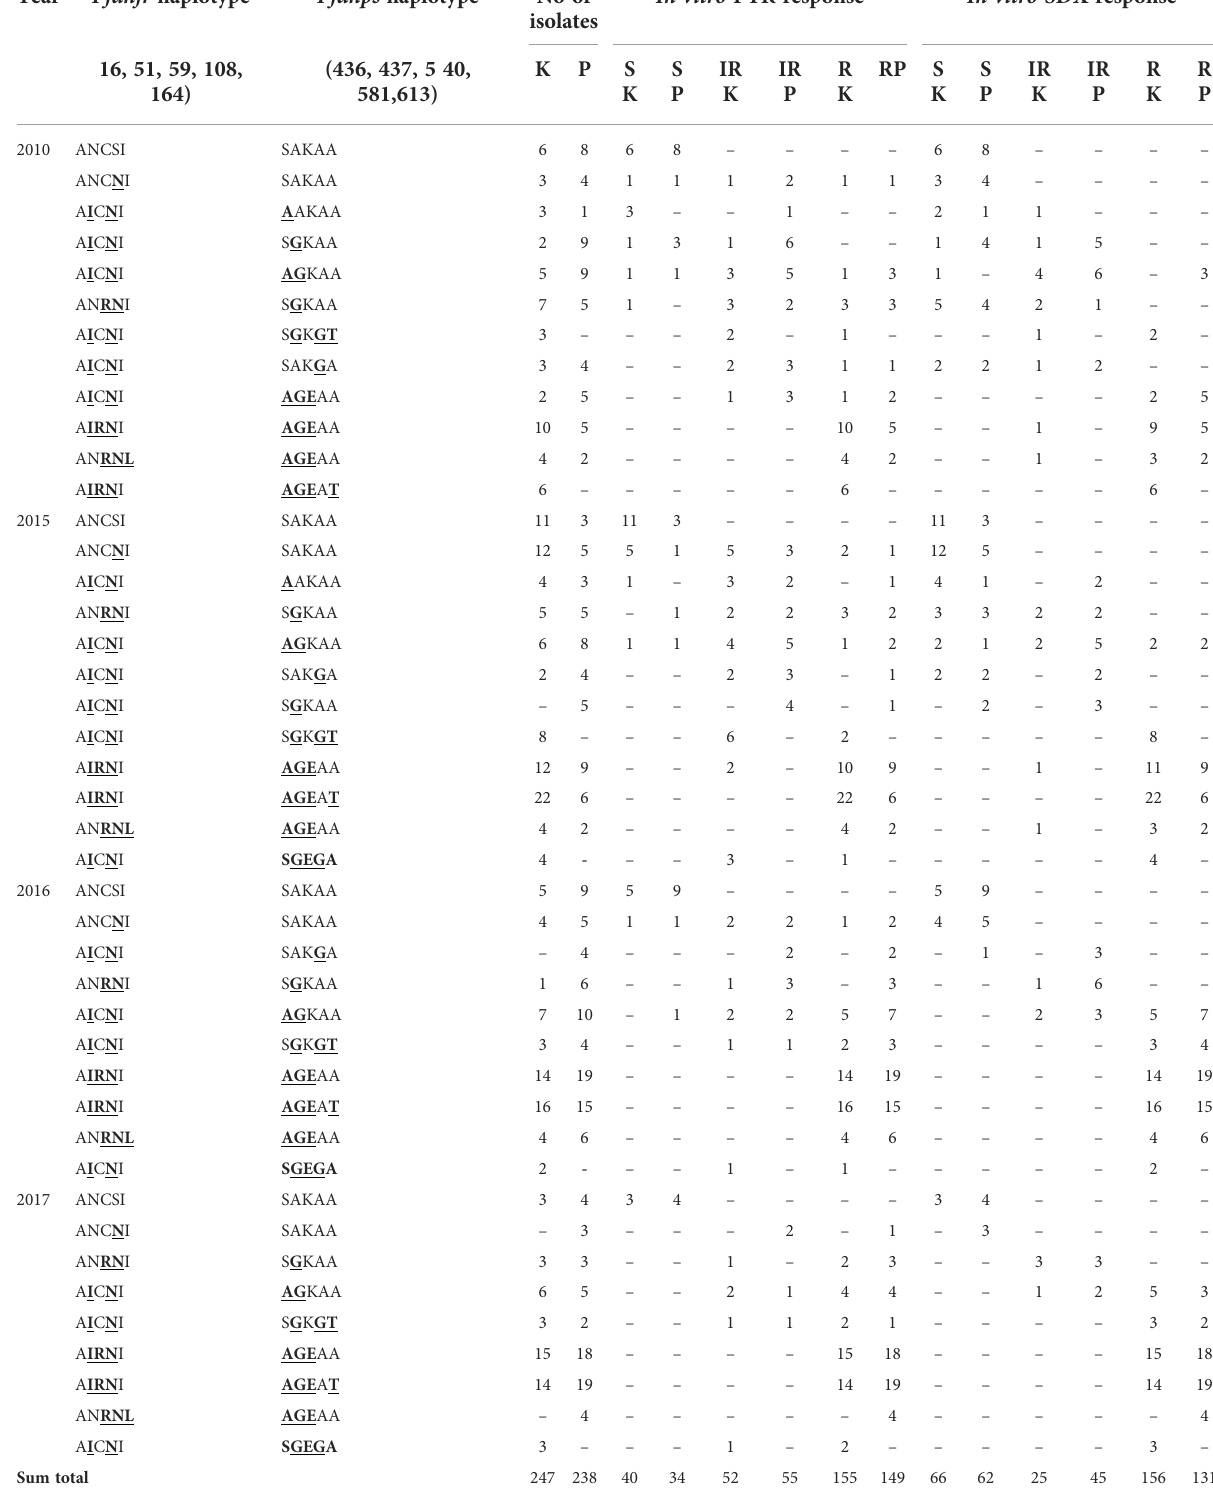
TABLE 3 dhfr and dhps haplotypes in relation to in vitro SP sensitivity after new drug